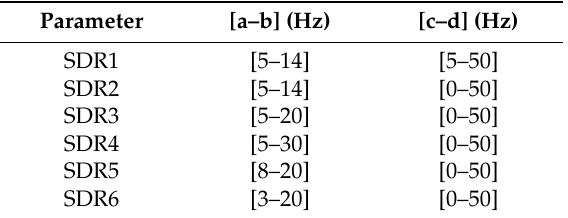
Table 1. Spectral ranges for the 6 SDR calculated quality